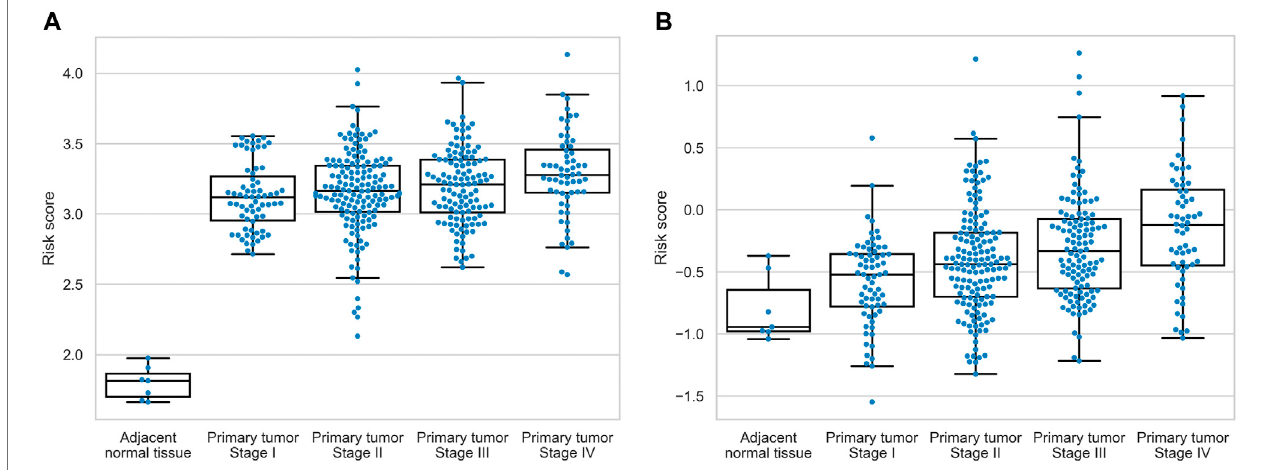
FIGURE 6 | Distribution of the risk scores across normal tissues and four stages of colorectal cancer. (A) hsa-miR-32-5p|0, NR1H2, and SNAI1 signature. (B) AGRN, DAG1, FN1, ITGA5, THBS3, and TNC signature.